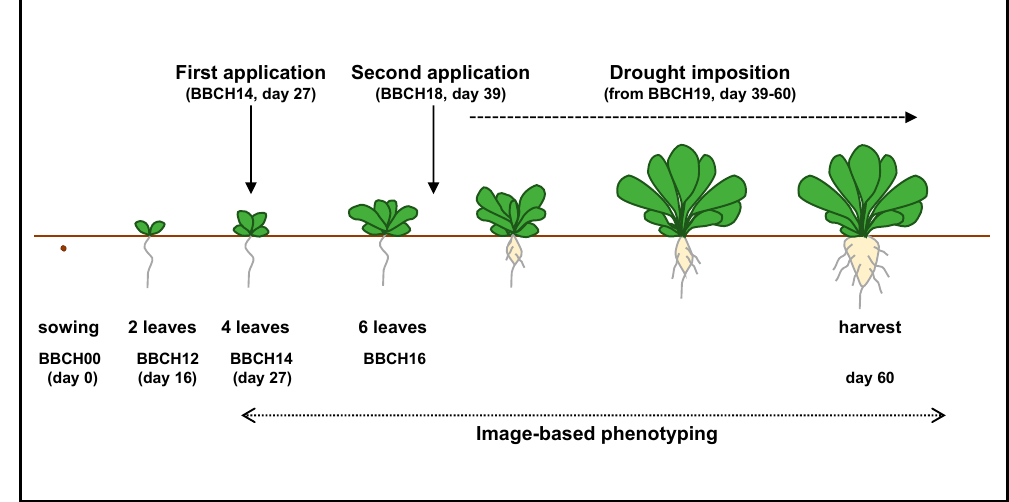
Figure 7. Schematic representation of experimental design. After seed germination, the seedlings were grown for 8 weeks in the Roullier high-throughput plant phenotyping platform. Foliar application of Ca 2+ was supplied twice at BBCH14 and BBCH18, each time with a dose of 5 L ha − 1 corresponding to 540 g Ca ha -1 . Drought stress (30% field capacity) was imposed 2 days after the second application of Ca 2+ for a duration of 3 weeks, while control plants were kept in 90% of field capacity. From BBCH14 till end of the experiment, image-based phenotyping was applied every 4 days. All plants were harvested at 60 days after sowing for different physiological, biochemical, and molecular analyses.